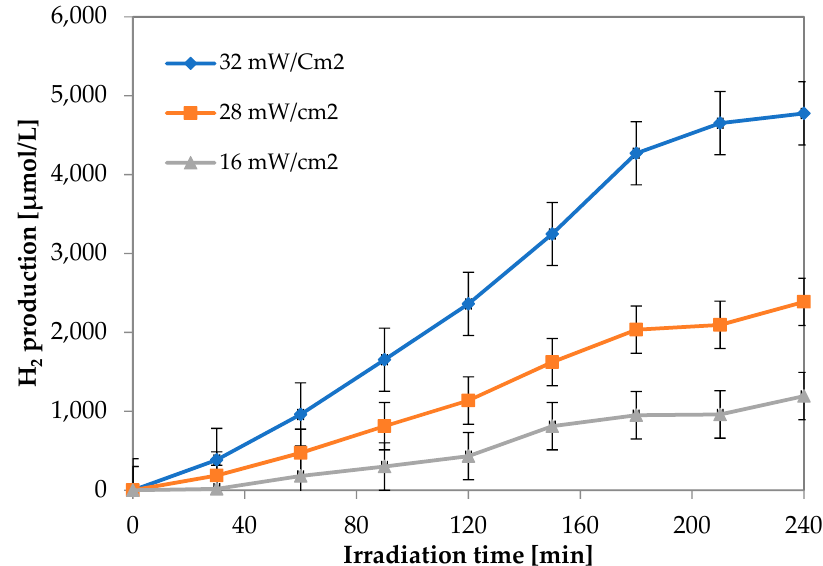
Figure 6. Photocatalytic hydrogen production for different visible light intensities. Initial glycerol concentration: 10 wt %; catalyst dosage: 1.5 g/L.